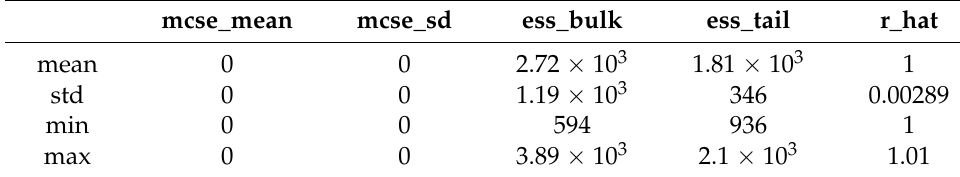
Table 4. Convergence results summary for house and apartments model.